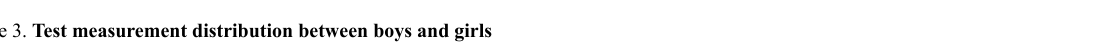
Table 3. Test measurement distribution between boys and girls